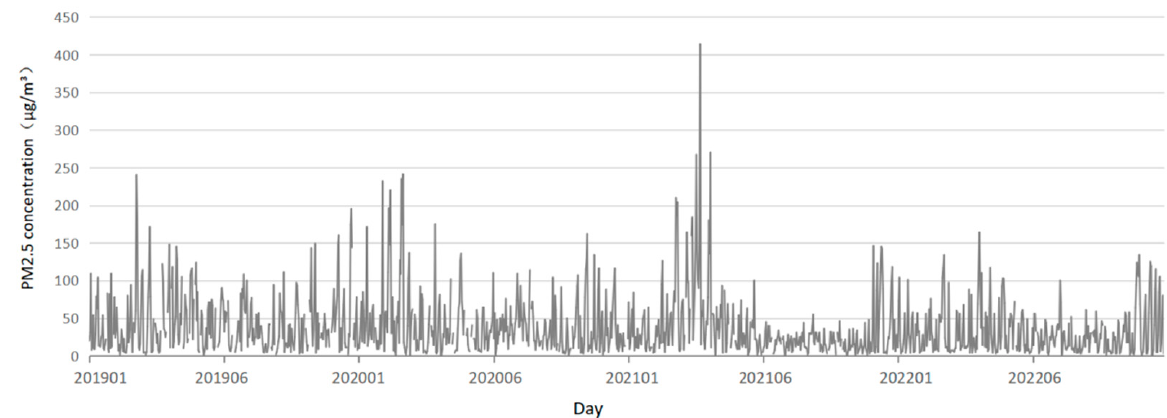
Figure 8. The trends of PM 2.5 concentration from January 2019 to October 2022.